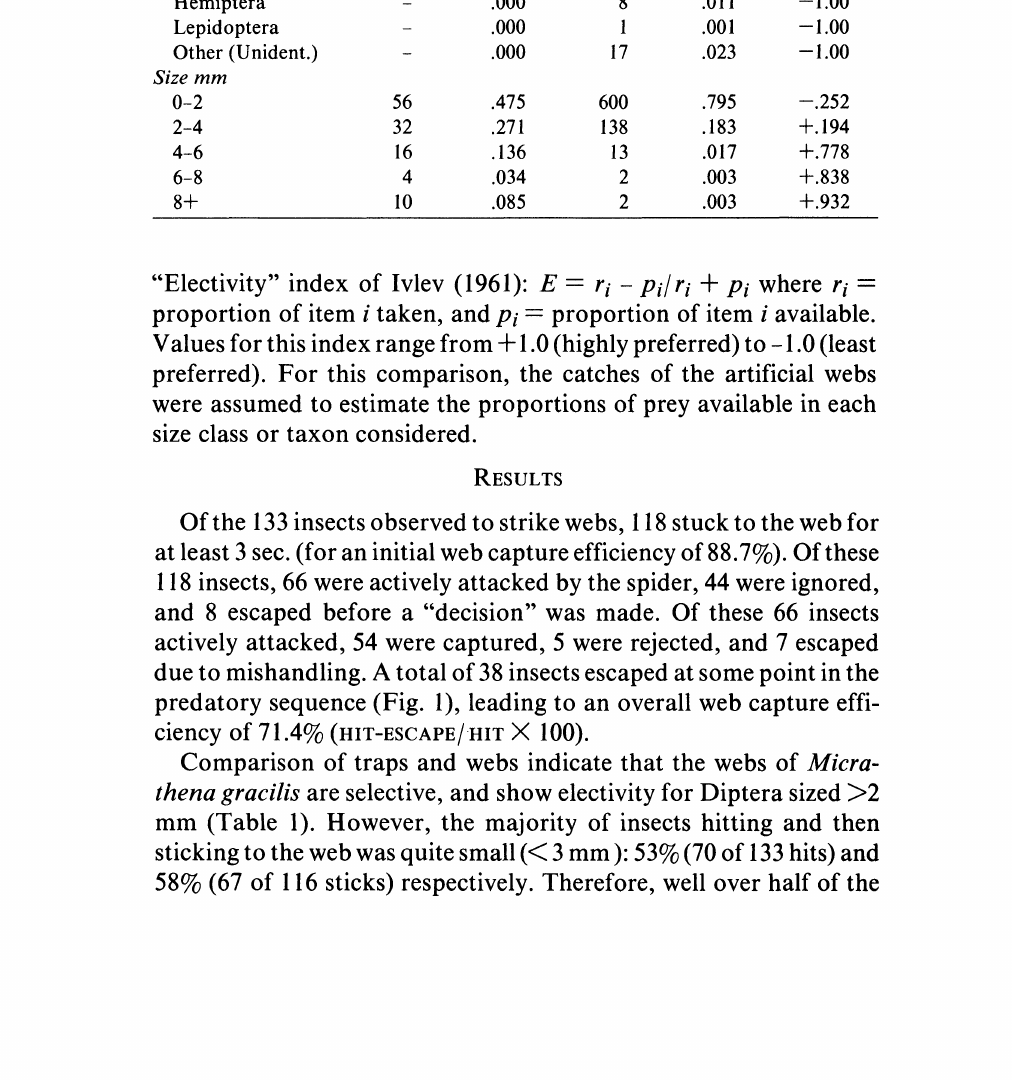
Table 1. Web selectivity (Ew) values for prey types and sizes caught in webs of Micrathena gracilis Caught in spider